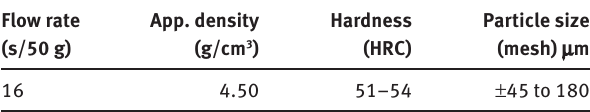
Table 3: Physical properties of hardfaced